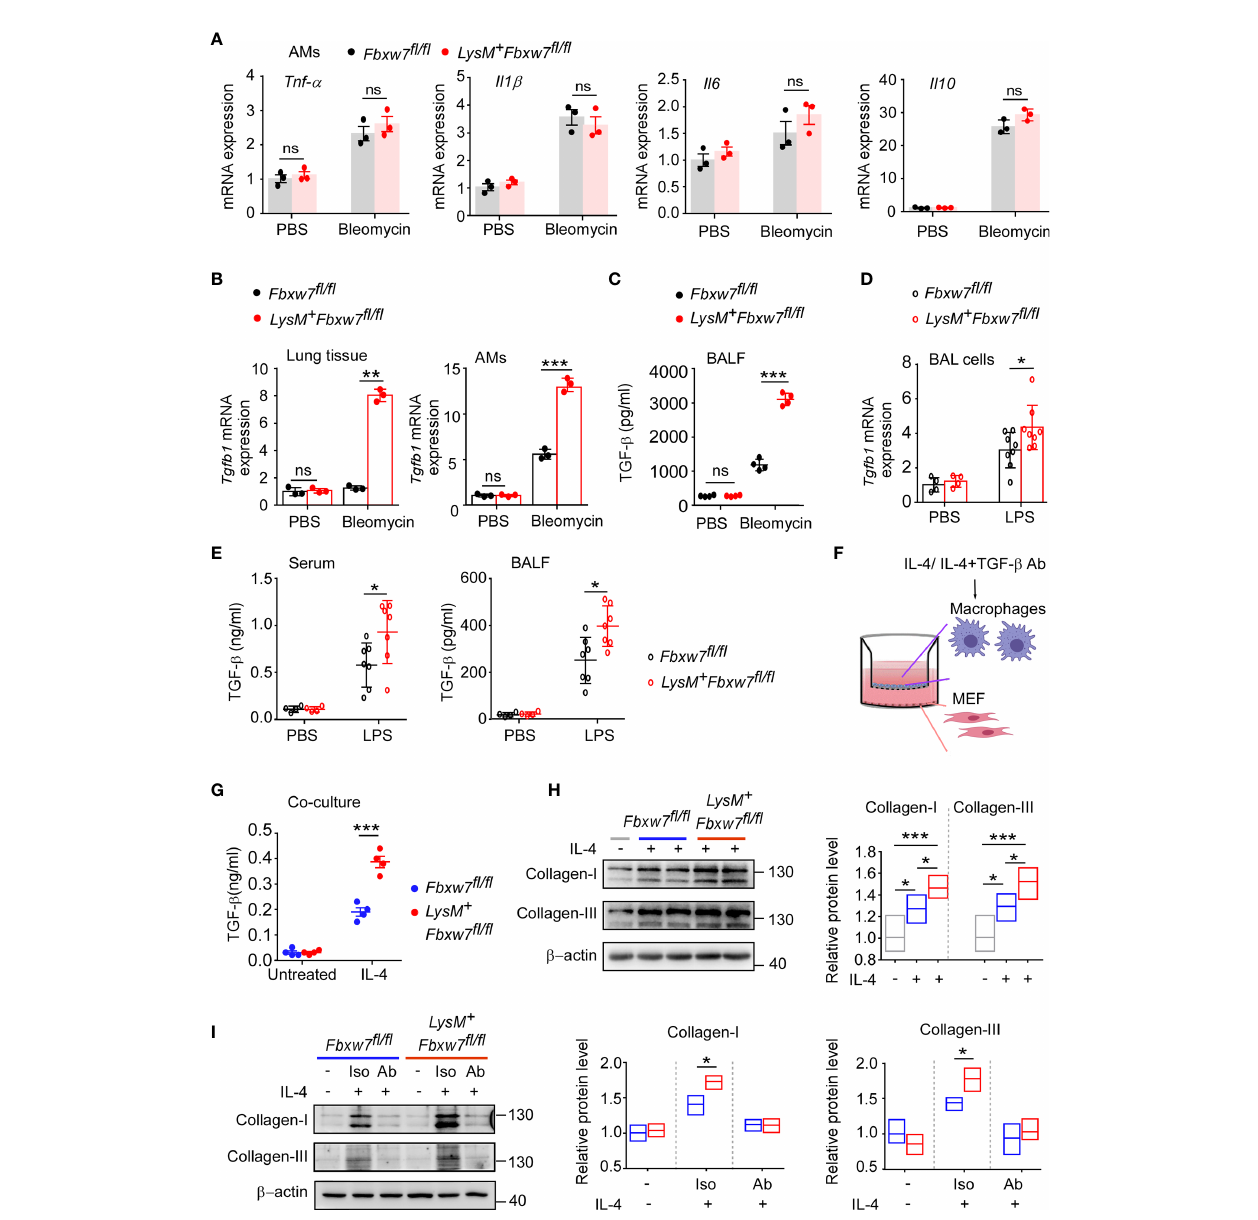
FIGURE 4 | Fbxw7 deletion upregulates TGF- b expression in lung fi brosis model induced by bleomycin. qRT-PCR analysis of Tnf- a , Il1 b , Il6 , and Il10 relative mRNA expression of AMs (A) after Fbxw7 fl / fl and LysM + Fbxw7 fl / fl mice were administered PBS or bleomycin for 21 days to induce pulmonary fi brosis. After a 21d period of bleomycin-induced lung injure, qRT-PCR analysis of Tgfb1 relative mRNA expression in lung tissue and AMs (B) , TGF- b content in BALF was detected by ELISA (C) . Tgfb1 relative mRNA expression in BAL cells was analyzed by qRT-PCR (D) , TGF- b content in serum and BALF was detected by ELISA (E) after 10 days of LPS- induced lung injury. Macrophages from Fbxw7 fl / fl and LysM + Fbxw7 fl / fl mice were stimulated with IL-4 (30 ng/ml) and treated with or without TGF- b neutralizing antibody for 12 h, then co-cultured with MEF for another 48 h. (F) The schematics of the approach. (G) TGF- b in the media of the macrophage co-culture system. Data are expressed as mean ± SD of biological duplicates (n ≥ 3) and are the representative of three independent experiments. P values were obtained using two- tailed Student ’ s t test, * P < 0.05, ** P < 0.01, *** P < 0.001, ns, not signi fi cant. (H) Representative images of western blot analysis of collagen-I and collagen-III in co- cultured MEF after IL-4 treatment. Densitometric fold change of target proteins based on IL-4 untreated group was calculated. (I) Representative images of